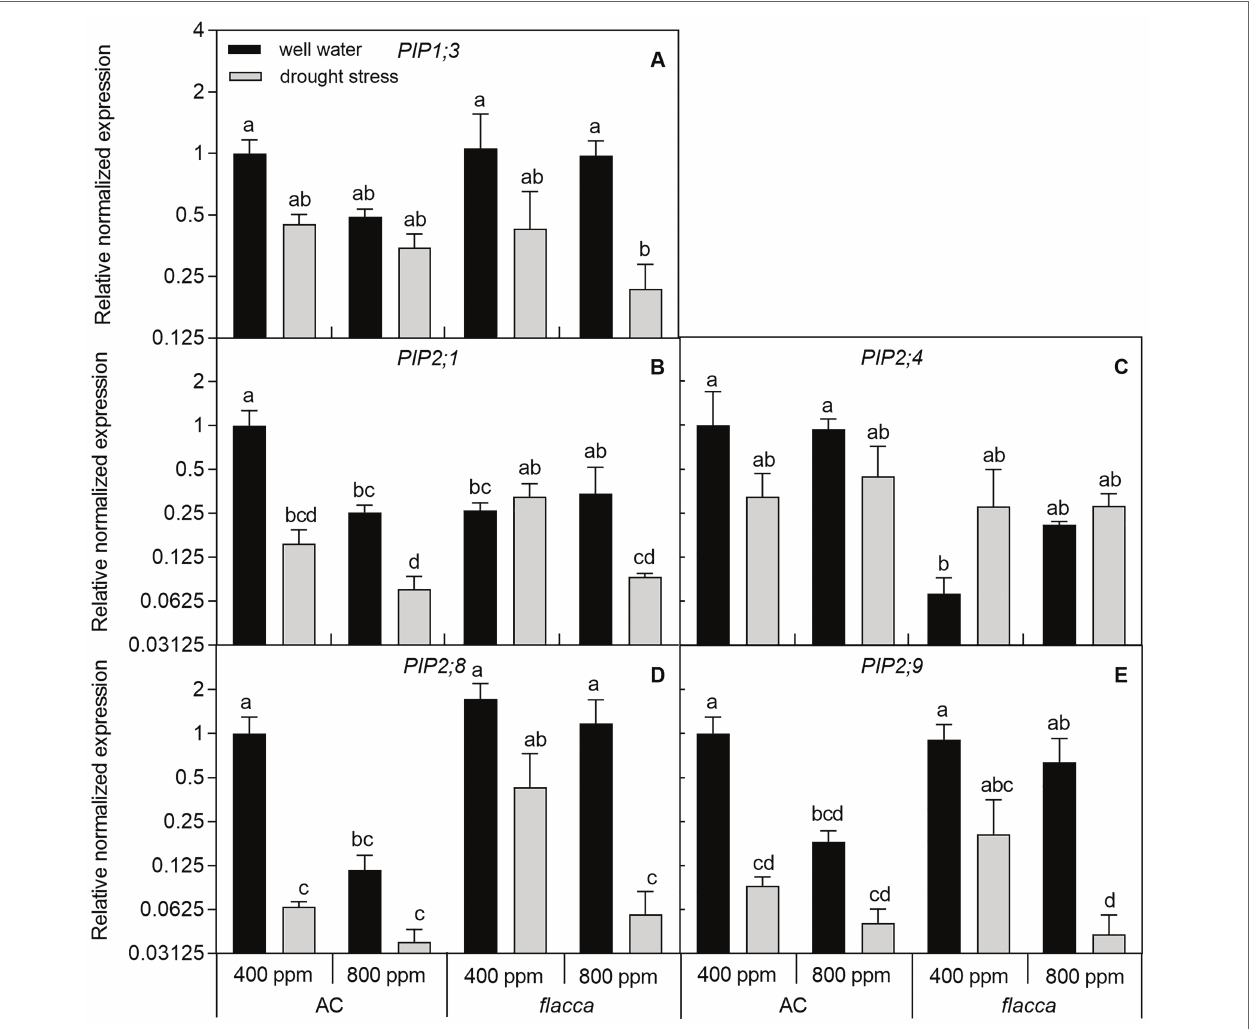
FIGURE 5 | Relative expression levels of genes encoding aquaporin subfamily of the plasma membrane intrinsic proteins (PIPs; A-E ) in leaves of AC and flacca grown under ambient (400 ppm) and elevated (800 ppm) atmospheric CO 2 concentrations after progressive soil drying. Gray columns indicate plants grown under well-watered conditions, and white columns indicate plants grown under drought stress. Different letters on the top of the columns for each PIP gene indicate significant difference between the treatments by Tukey’s test at p < 0.05. Error bars indicate standard error of the means (SE; N =